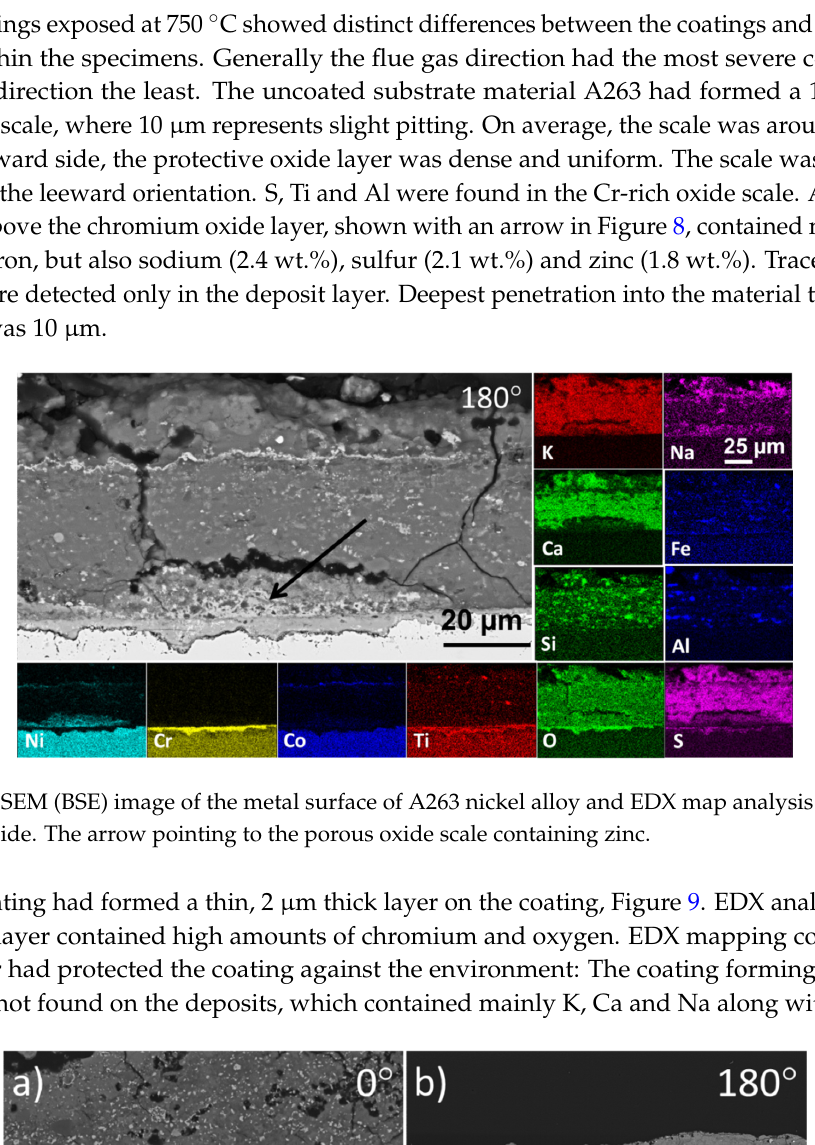
Figure 9. SEM (BSE) images of NiCr coating after the exposure at 750  C for 1300 h: ( a ) windward and ( b ) leeward side.